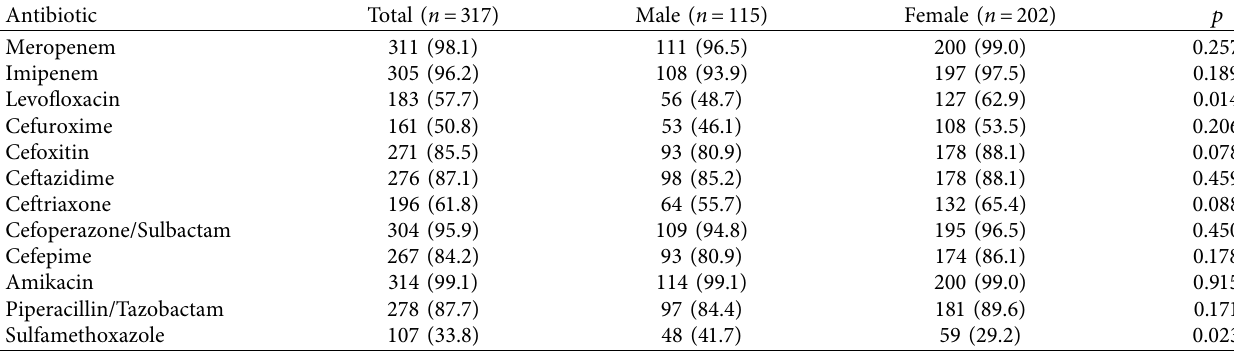
Table 2: Sex distribution of Proteus mirabilis urinary tract infections in patients with urinary stones (%). Antibiotic